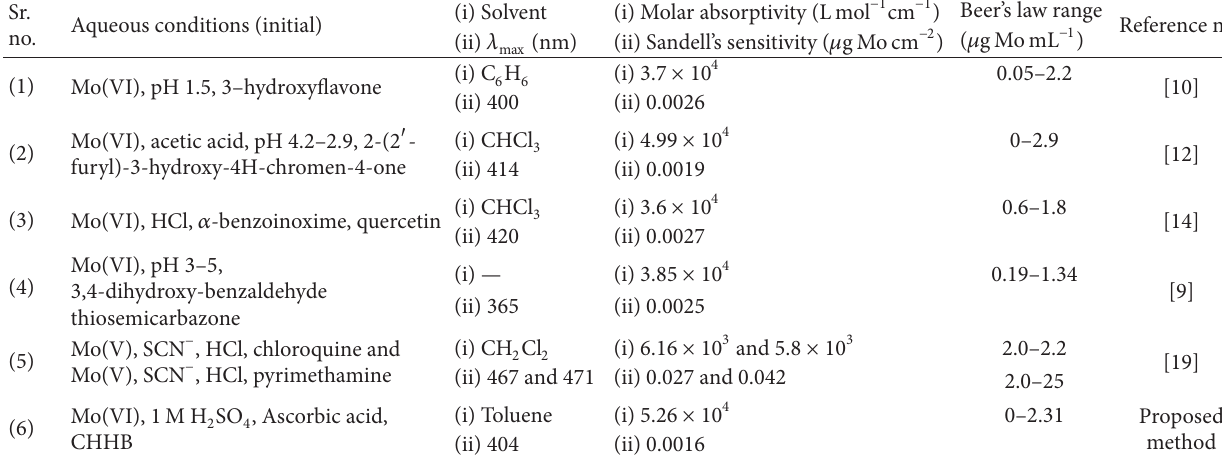
T 2: Comparison of the proposed method with the existing methods of molybdenum determination. Sr.